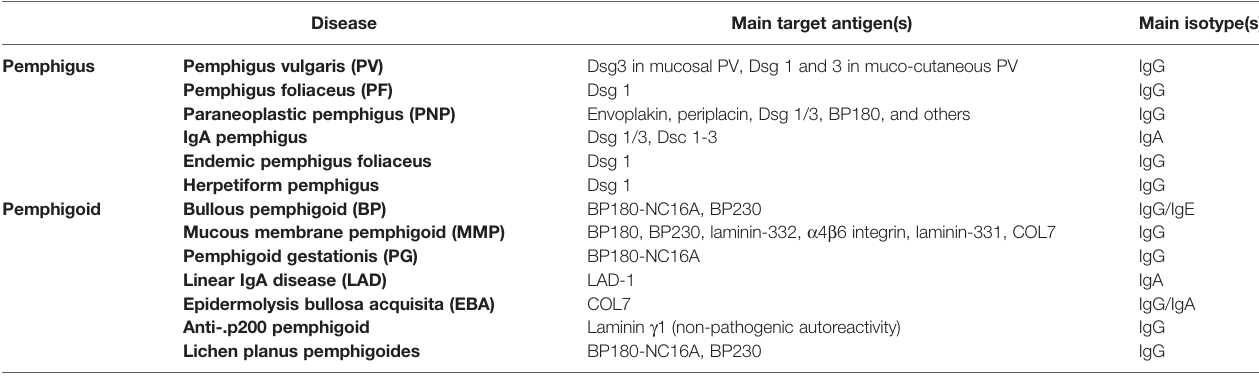
TABLE 1 | Autoantigens in pemphigus and